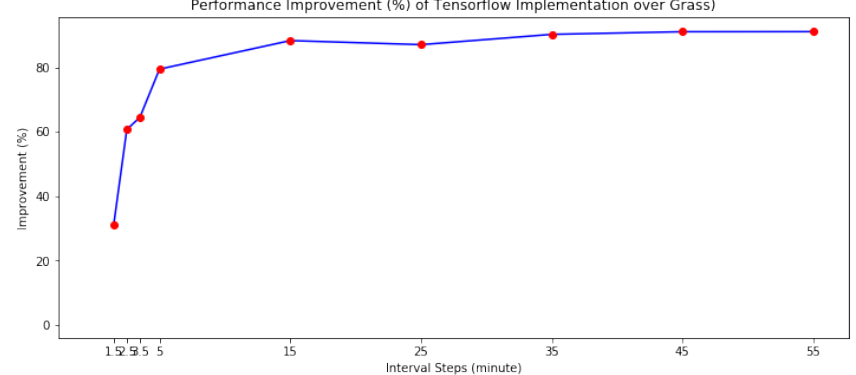
Figure 13. Performance